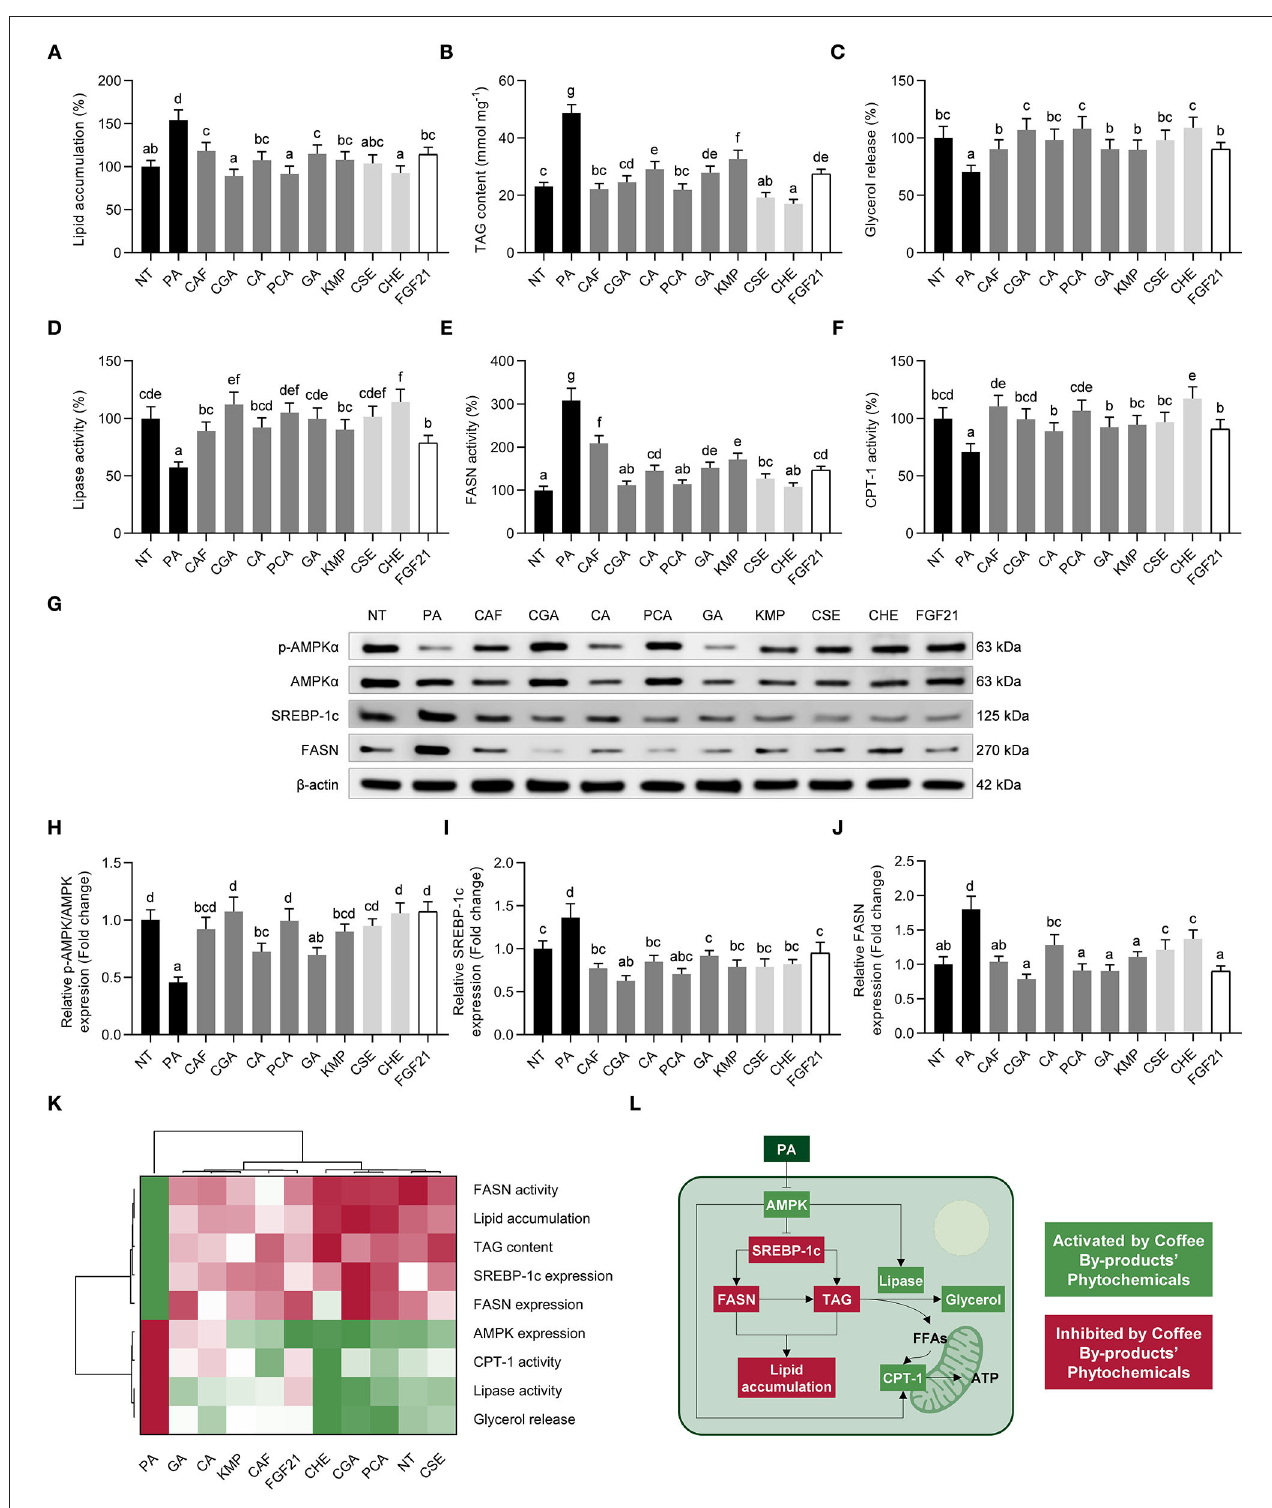
FIGURE 7 | Modulatory effects of standard solutions of the bioactive compounds from coffee by-products (50 µ mol L − 1 ), aqueous extracts (CSE and CHE, 100 µ g mL − 1 ), and FGF21 (20 nmol L − 1 ), in the presence of palmitic acid (500 µ mol L − 1 ) on lipid metabolism in HepG2 human hepatocytes. Palmitic